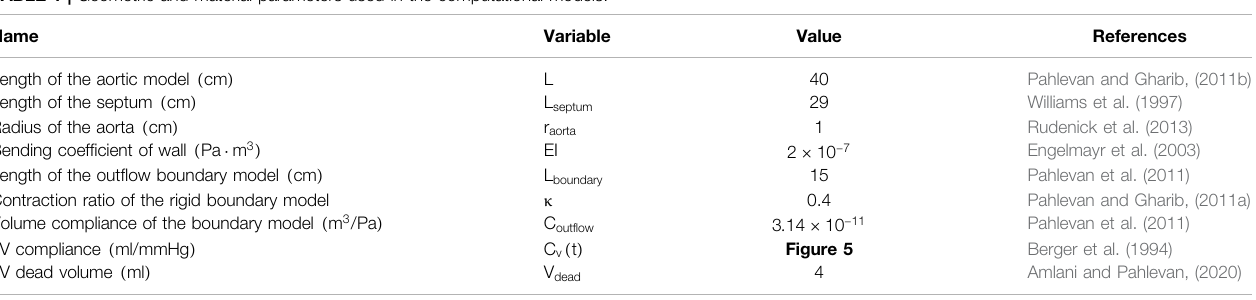
TABLE 1 | Geometric and material parameters used in the computational